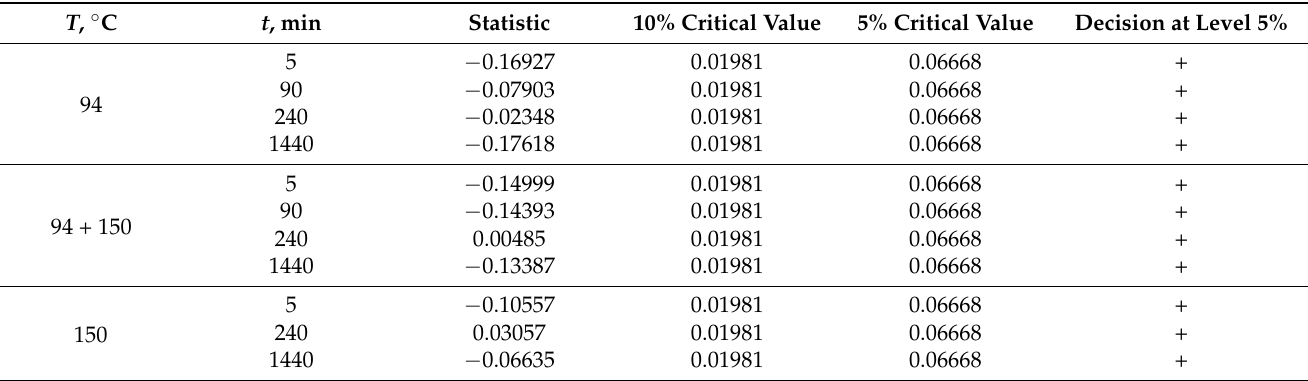
Table 4. Statistical parameters of the lap shear strength distribution for PET–PET interfaces estimated from the Chen–Shapiro normality test.